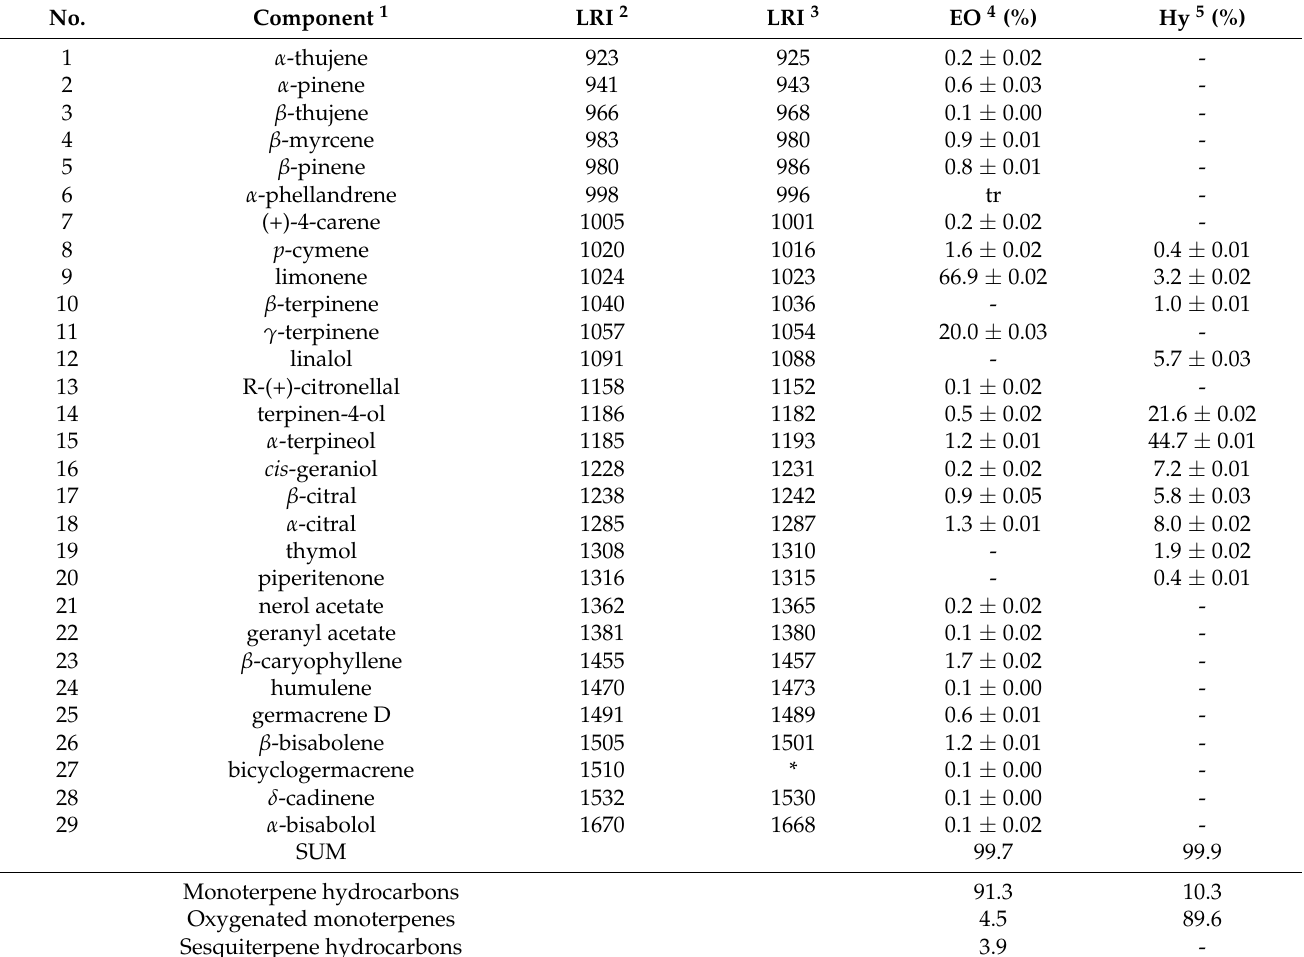
Table 3. Chemical composition (percentage mean value ± standard deviation) of EO and